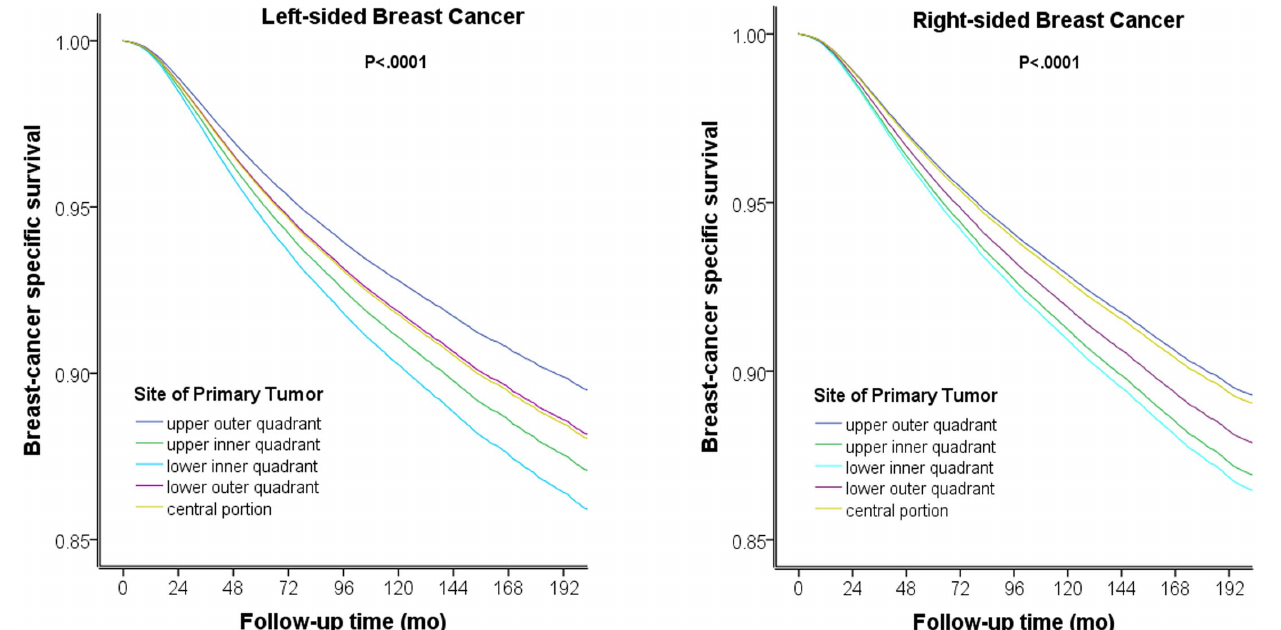
Figure 3. Survival Curves Stratified According to the Primary Tumor Site for Breast Cancer. The survival curves stratified according to primary tumor site for both sides indicate that primary tumors on the left and right side display different effects BCSM. For left-side breast cancer, patients with central portion tumors had a similar prognosis as patients with lower-outer quadrant tumors (A). For right-sided breast cancer, patients with central portion tumors displayed survival similar to patients with upper-outer quadrant tumors (B).